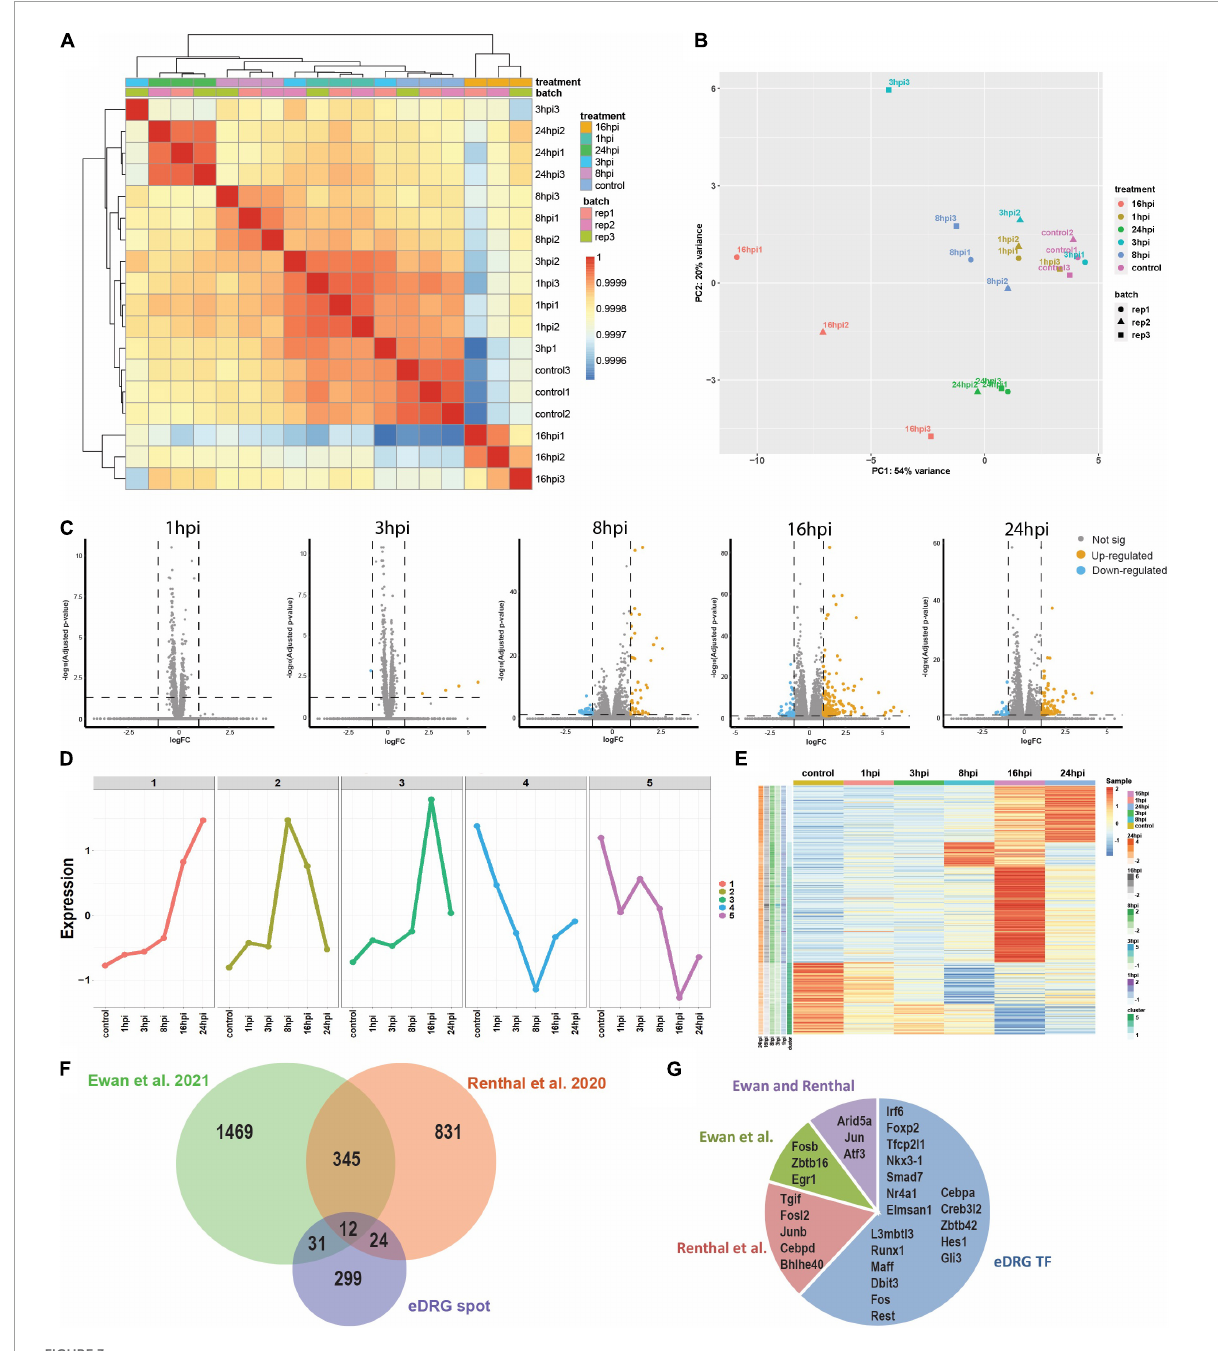
FIGURE3 Time course analysis (1, 3, 8, 16, and 24 h) of the transcriptional response to injury in eDRG spot culture. (A) Heatmap of correlation of samples from time-course RNAseq analysis after axotomy. (B) PCA analysis of time-course RNAseq analysis after axotomy illustrates the relative similarity between sample groups at control, 1, 3, 8, 16, and 24 hpi (3 replicates per time point). (C) Volcano plots of differentially regulated genes after injury ( p adj < 0.05, FC > 2). (D) K-means clustering identified five unique gene profile clusters with similar gene expression dynamics according to the time-course gene expression data. (E) Heatmap shows the scale z-score of the average CPM of 365 differentially expressed genes from time-course data. Red and blue cells indicate relative gene upregulation and downregulation, respectively. Green cells indicate cluster types identified in D. the cells next to cluster type are genes that are significantly expressed at different time points between treated and control groups. (F) Venn diagram comparing the differentially expressed genes after injury in the eDRG spot culture and 2 datasets of in vivo adult injury using enriched neuronal populations. (G) Out of the 29 up-regulated TFs in the eDRG spot, 11 were also identified in adult DRG neurons following sciatic nerve